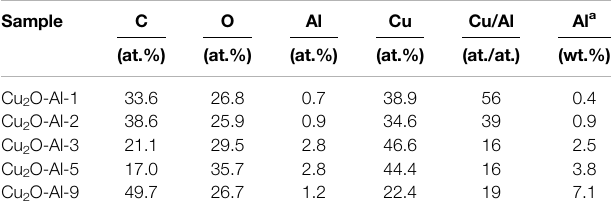
TABLE 2 | Element distribution by EDX on various Cu 2 O-Al-x